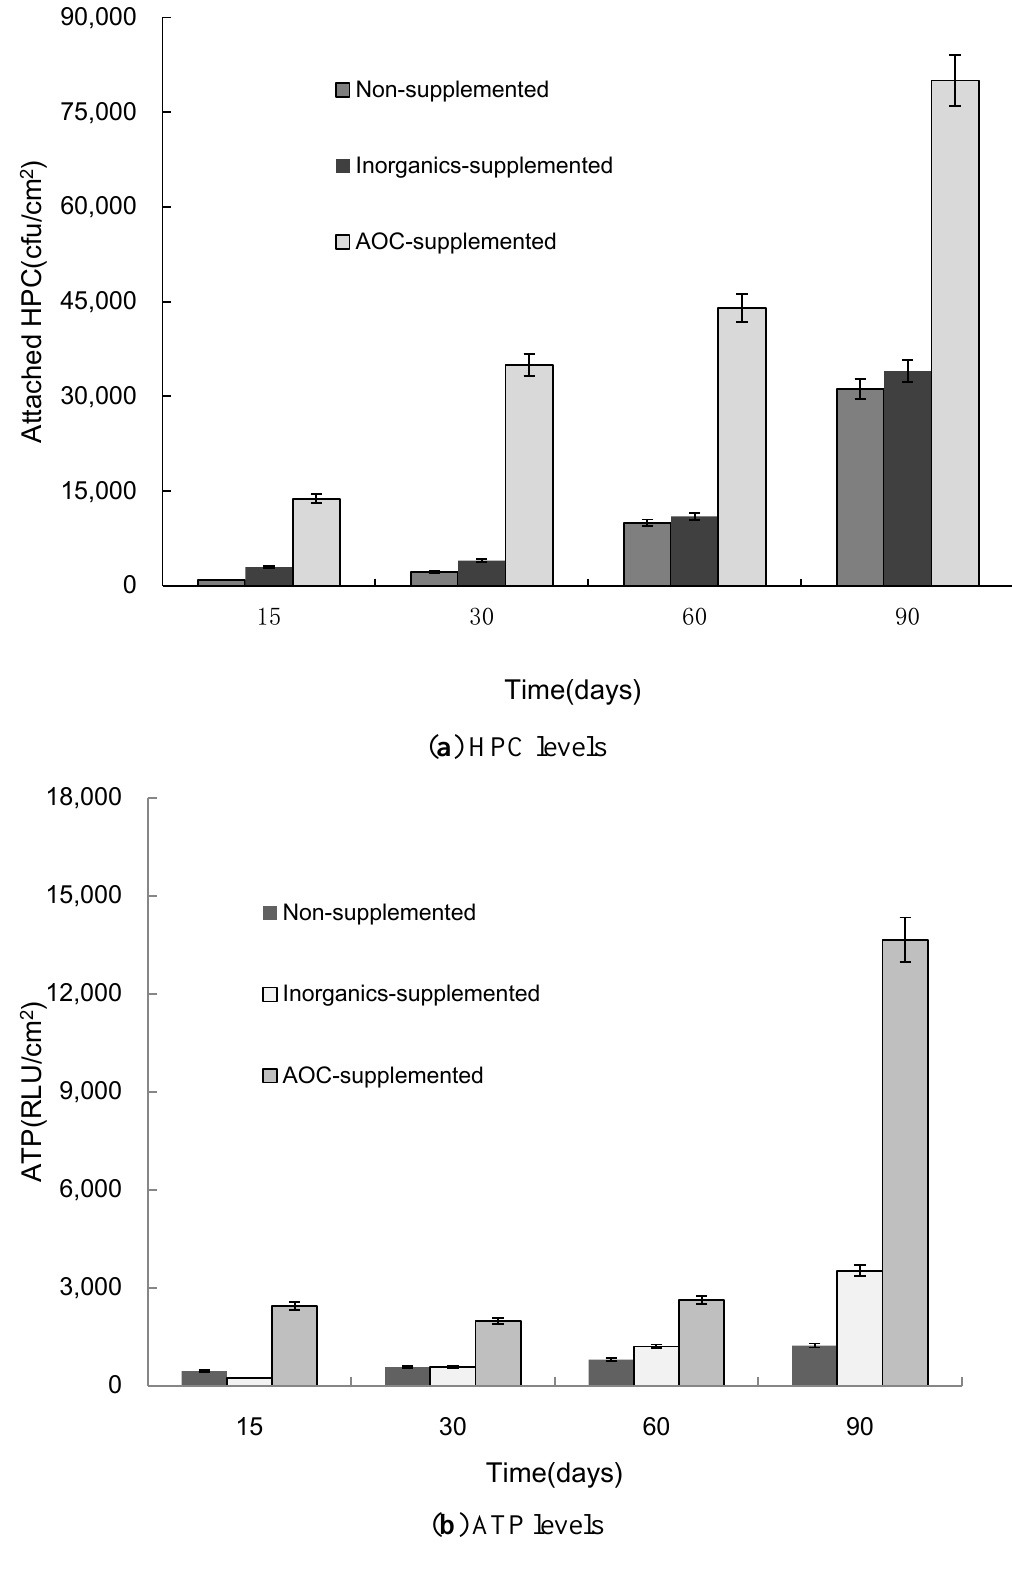
Figure 4. Biofilm accumulation on stainless steel pipe, as assessed with HPC and ATP level, on PEX pipes in the control experimental condition and with the addition of 3 mg/L acetate and an inorganic cocktail in tap